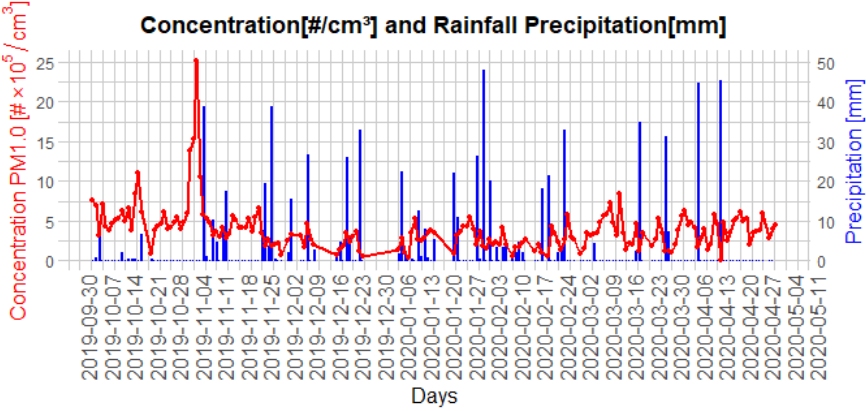
Figure 10. The concentration of suspended particles in the and the rainfall precipitation levels from